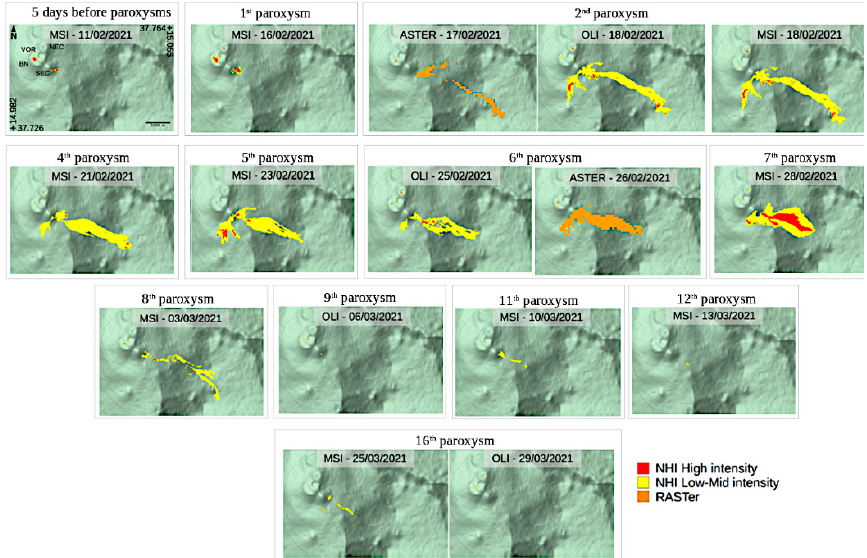
Figure 3. Thermal anomaly maps generated using the NHI tool (red/yellow pixels) and the RASTer (orange pixels) system. Maps show the thermal anomaly at the summit craters, and the detected lava flows associated with paroxysms at SEC.